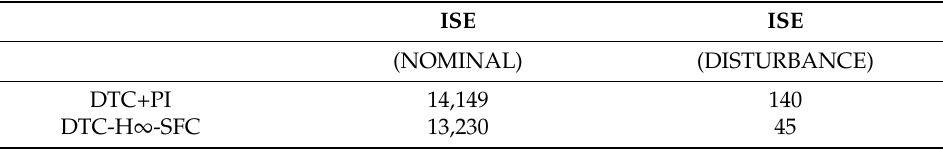
Table 2. Comparative results of integral squared error (ISE) performance index of the control system with the DTC-H ∞ -SFC and DTC+PI designed controllers and external disturbance. ISE